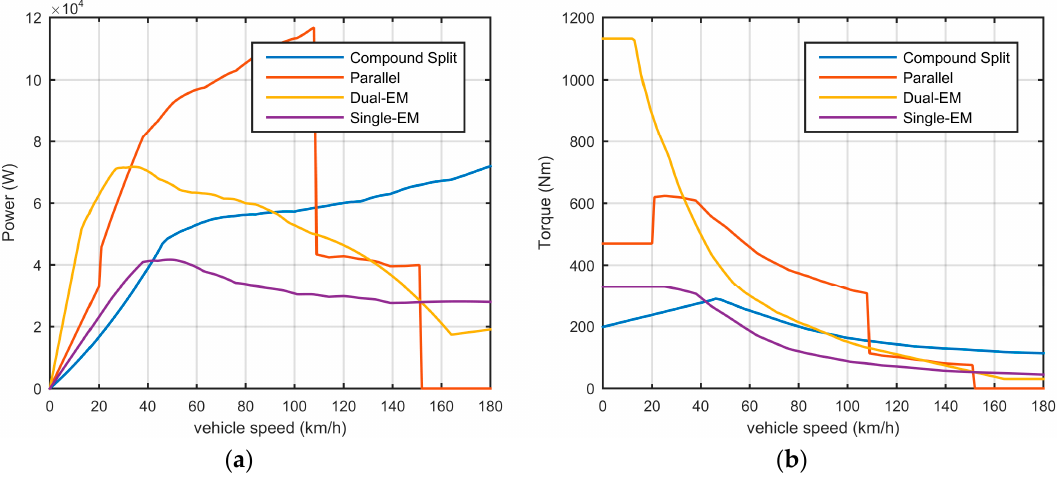
Figure 2. ( a ) Maximum output power of each mode versus vehicle speed; and ( b ) maximum output torque of each mode versus vehicle speed.